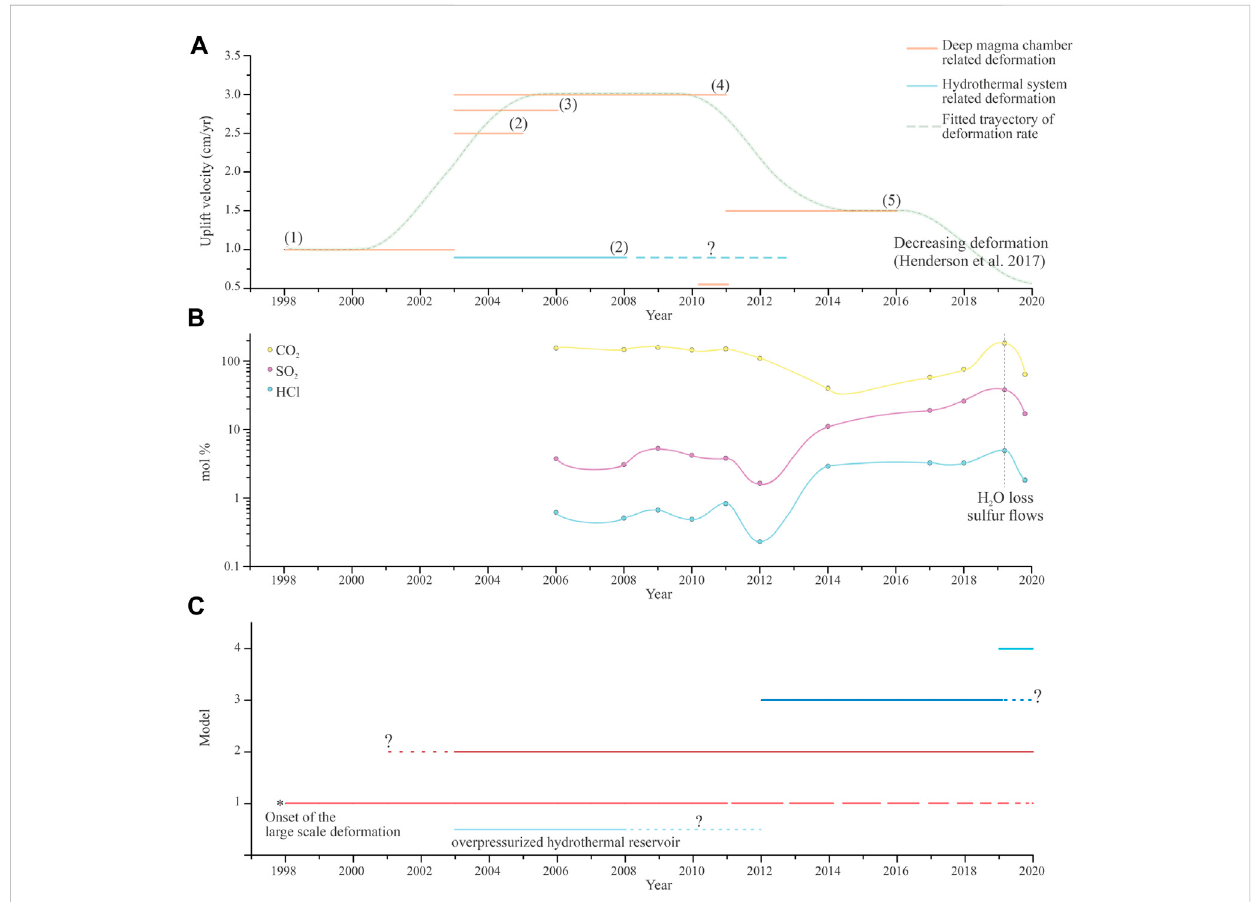
FIGURE 7 Time series of (A) ground deformation data, (B) direct sampling degassing data, and (C) the sequence of mechanisms that explain degassing/ deformation processes. In thediagrams (A) theorangelines correspond to thedeformation related to thedeep magma chamber, theblueone related to the shallow hydrothermal system deformation, and the green short-dashed line corresponds to a fi tted possible trajectory of the deformation rate 1) Pritchard and Simons (2002), 2) Froger et al. (2007), 3) Ruch et al. (2008), 4) Pritchard et al. (2018), and 5) Henderson et al. (2017). In (B) , the black short-dashed line marks the occurrence of sulfur fl